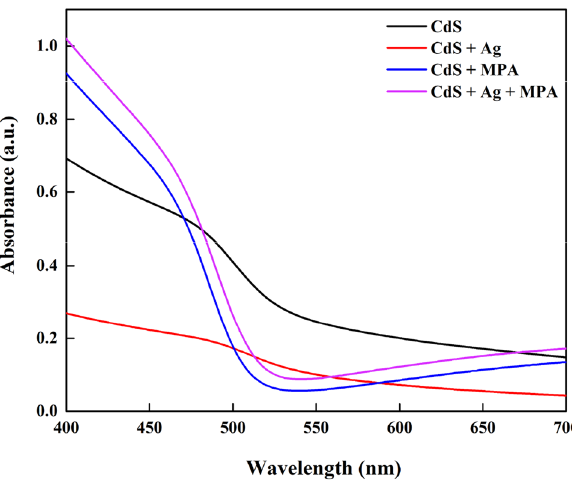
Figure 1. UV–Vis absorption spectra of the CdS thin